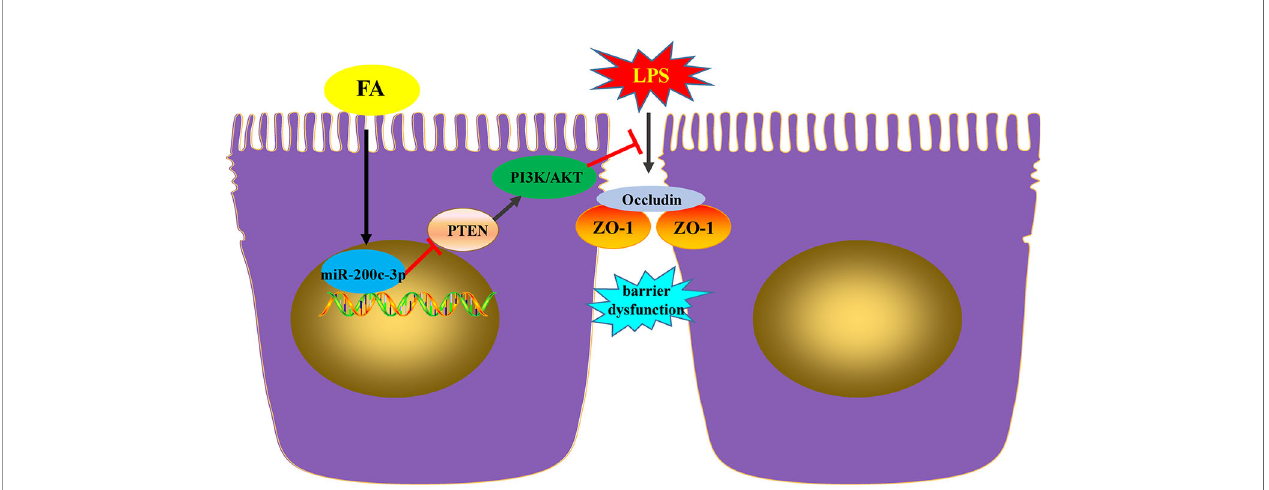
FIGURE 6 | FA ameliorated lipopolysaccharide-induced barrier dysfunction via miR-200c-3p-mediated activation of PI3K/AKT pathway in Caco-2 cells. FA exhibited the protective effects on LPS-induced barrier dysfunction involving in miR-200c-3p and PTEN/PI3K/Akt signaling pathway. FA promotes activation of PI3K/AKT pathway by miR-200c-3p-mediated suppression of the negative mediator PTEN, which, in turn, maintains TJ function and thus ameliorates LPS-induced intestinal epithelial barrier